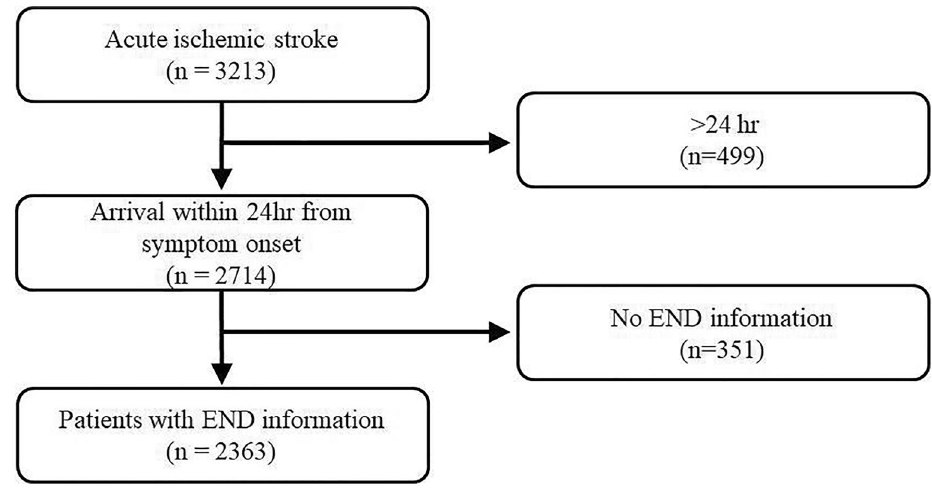
Figure 1. Flowchart of included